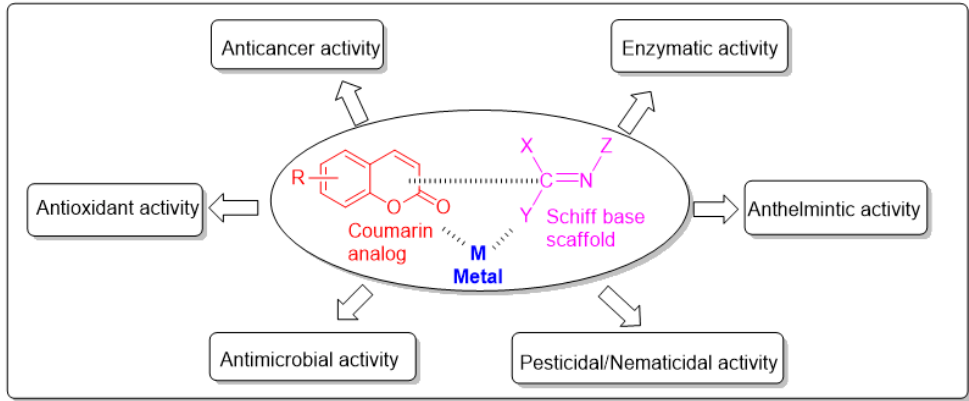
Figure 2. Important biological activities of the coumarin-derived imine–metal